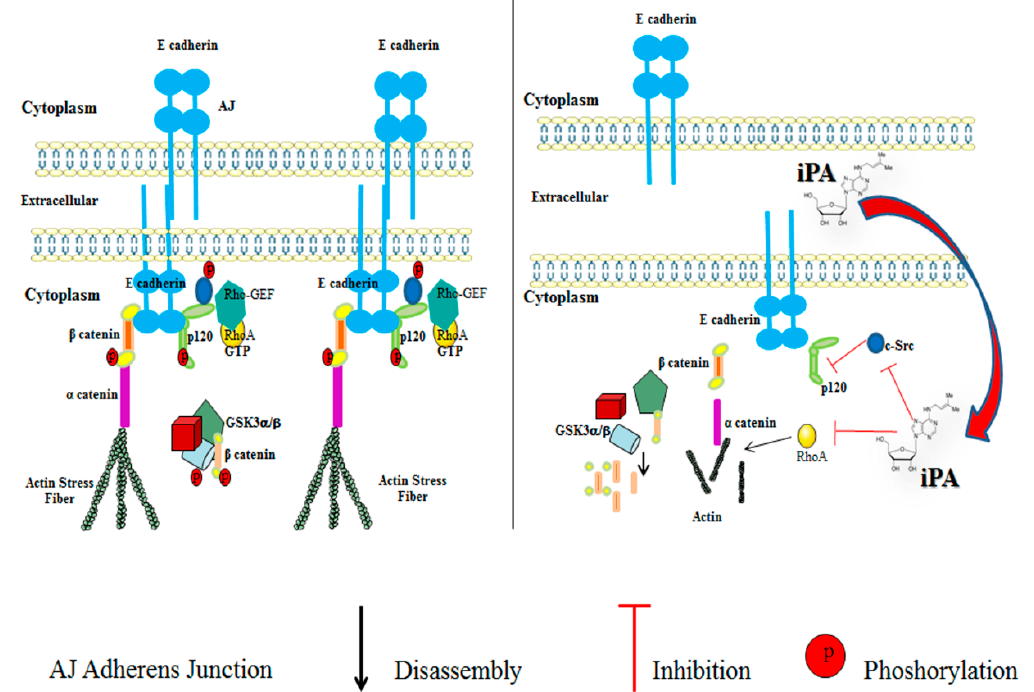
Figure 7. Schematic description of cells before and after iPA treatment. The major component of the AJs are the E-cadherins, which can pair with the E-cadherins exposed on the opposing cell. The mechanism leading up to adherens junction complex are still not clear, but they derive from the recruitment of cadherins, catenins (beta-catenins, alpha-catenins), and cytoskeletal proteins. Catenins and p120 catenin in their phosphorylated forms bind to the cytoplasmatic tail of the cadherins. A hypothetical model proposes that p120, phosphorylated by c-Src, can indirectly regulate RhoA activity. At the same time, β -catenin, through α -catenin, recruits the actin cytoskeleton, strengthening the cell compaction with the formation of stress fibers [42] iPA treatment causes the inhibition and reduction in proteins involved in the AJs assembly. We showed that iPA inhibits c-Src kinase activity through the decrease in c-Src phosphorylation. This event leads to the inactivation of p120 catenin and the inhibition of GSK3 α / β and accordingly of α -catenin. In addition, iPA reduced the levels of E-cadherin determining the AJ disassembly. iPA, through the inhibition of RhoA activity, induces the reduction in actin stress fibers inhibiting cell migration, invasion, and VM